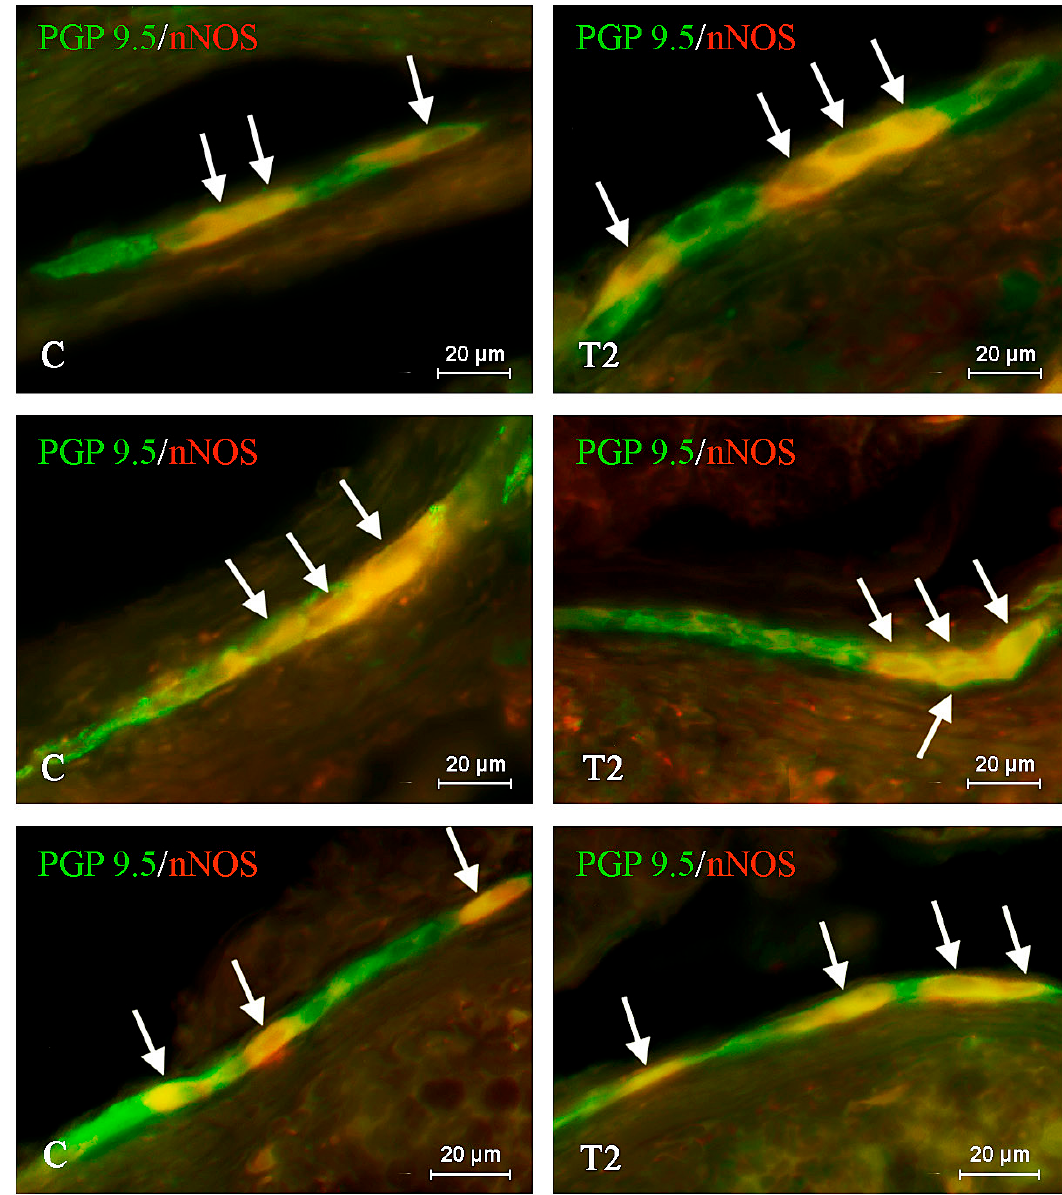
Figure 2. Distribution pattern of nerve cells immunoreactive to protein gene-product 9.5 (PGP 9.5)— used as pan neuronal marker and neuronal isoform of nitric oxide synthase (nNOS) in the outer submucous plexus of porcine duodenum under physiological conditions (C) and after T2-toxin administration (T2); the pictures are the result of the overlap of both stainings. The arrows are pointing neurons immunoreactive for both—PGP 9.5 and nNOS.